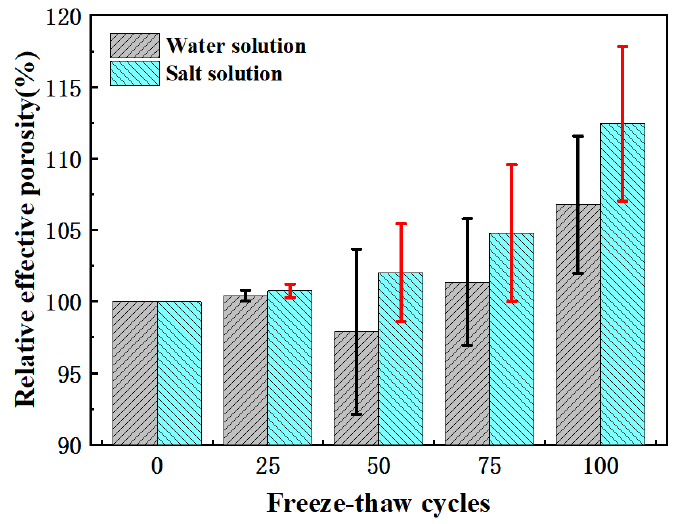
Figure 8. Relative effective porosity change of permeable concrete under freeze-thaw cycles.